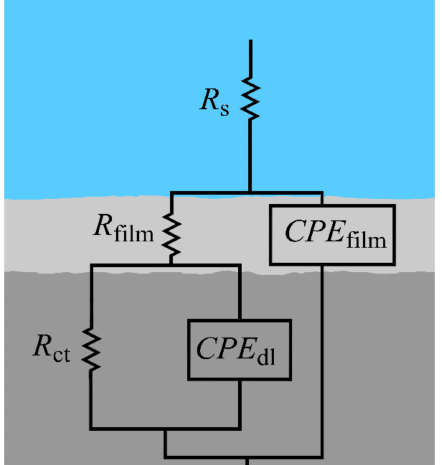
Figure 8. Proposed electrical equivalent circuit (EEC) to fit the EIS